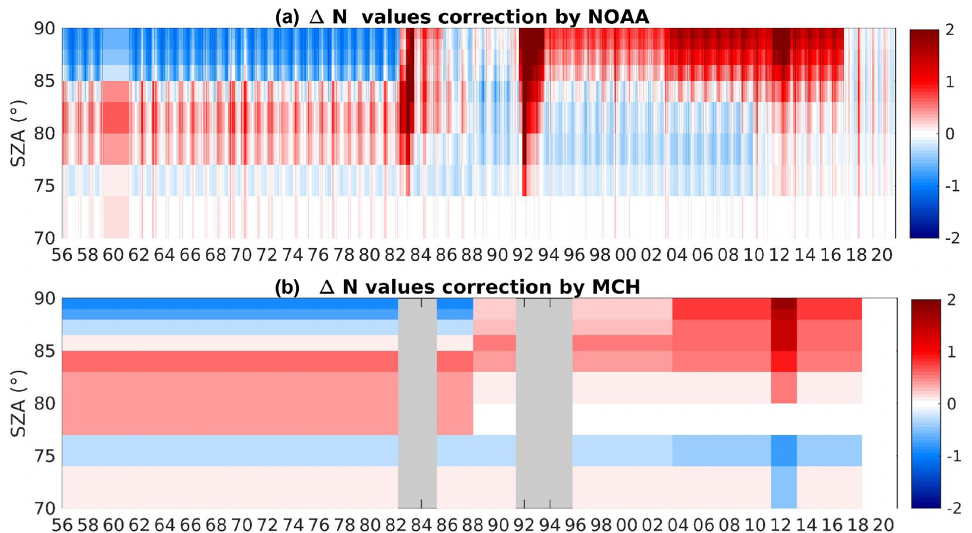
Figure 4. Monthly mean time series of the N value correction (a) for the NOAA and (b) for the MCH homogenization of the Dobson D051 dataset. Volcanic eruptions periods (grey shaded area) are not corrected by the MCH